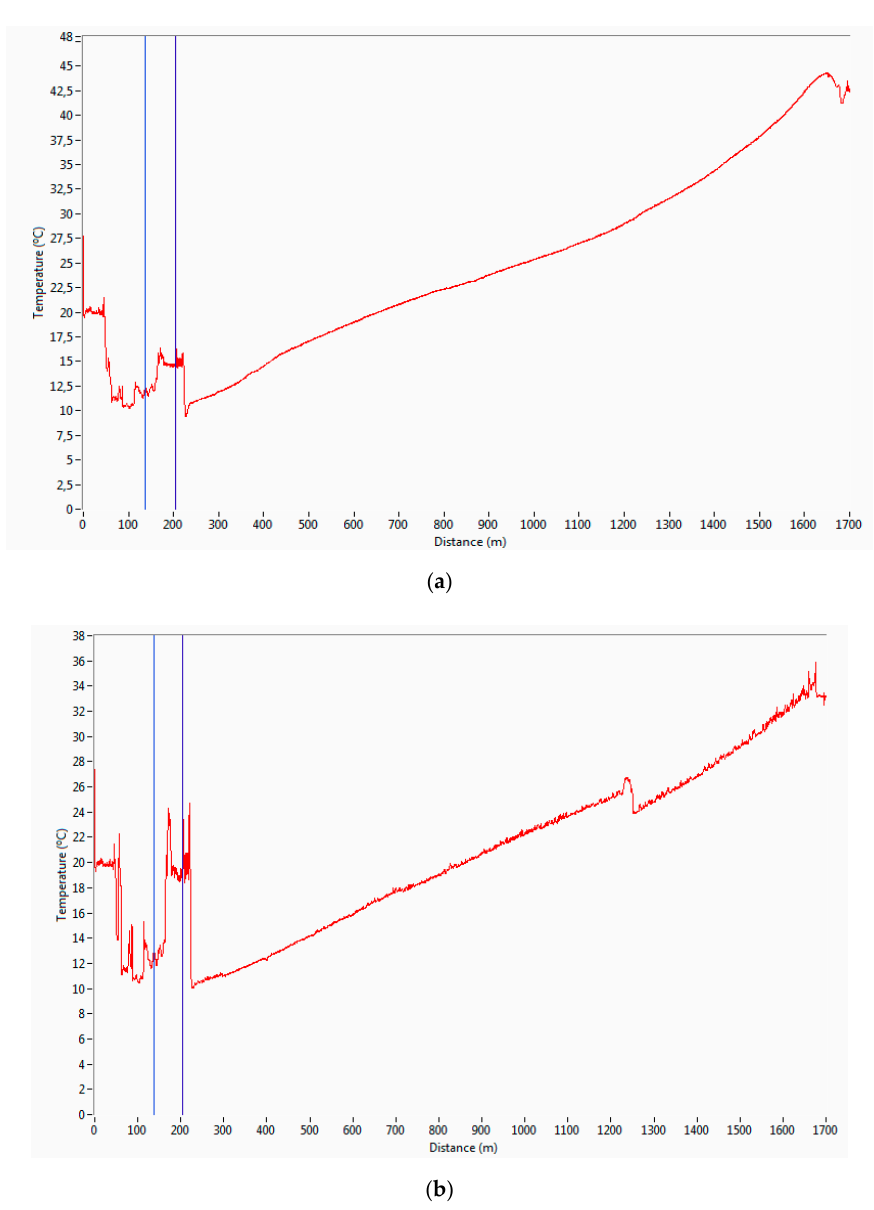
Figure 5. ( a ) The thermal profile of the HI well tubing prior to the CO 2 injection; ( b ) the thermal profile of the HI well tubing during the CO 2 injection.